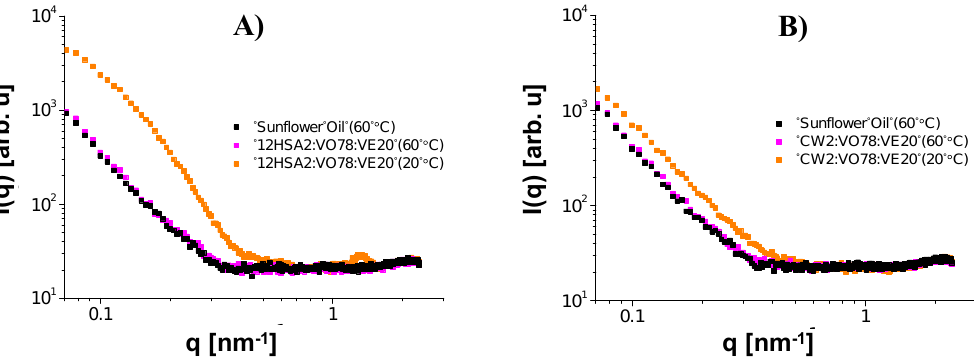
Figure 7. Comparison between the SAXS curves of sunflower oil at 60 ℃ , the major component of the organogels presented in this manuscript, and the samples containing 12HSA ( A ) and CW ( B ), at 60 and 20 ℃ . In this example, the curves collected at 60 ℃ are almost perfectly overlapped. This fact makes some of the treated curves presented in Figures 5 and 6 very noisy in all q values. For the other curves, like the ones collected at 20 ℃ , only their high q regions are noisy.